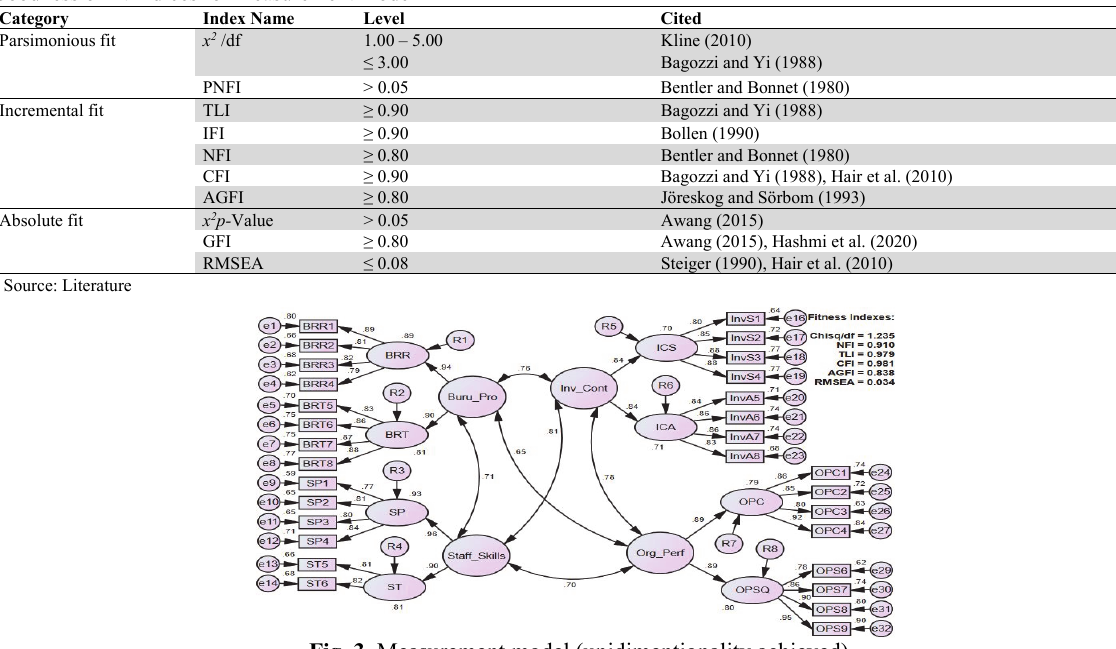
Fig. 3. Measurement model (unidimentionality achieved)